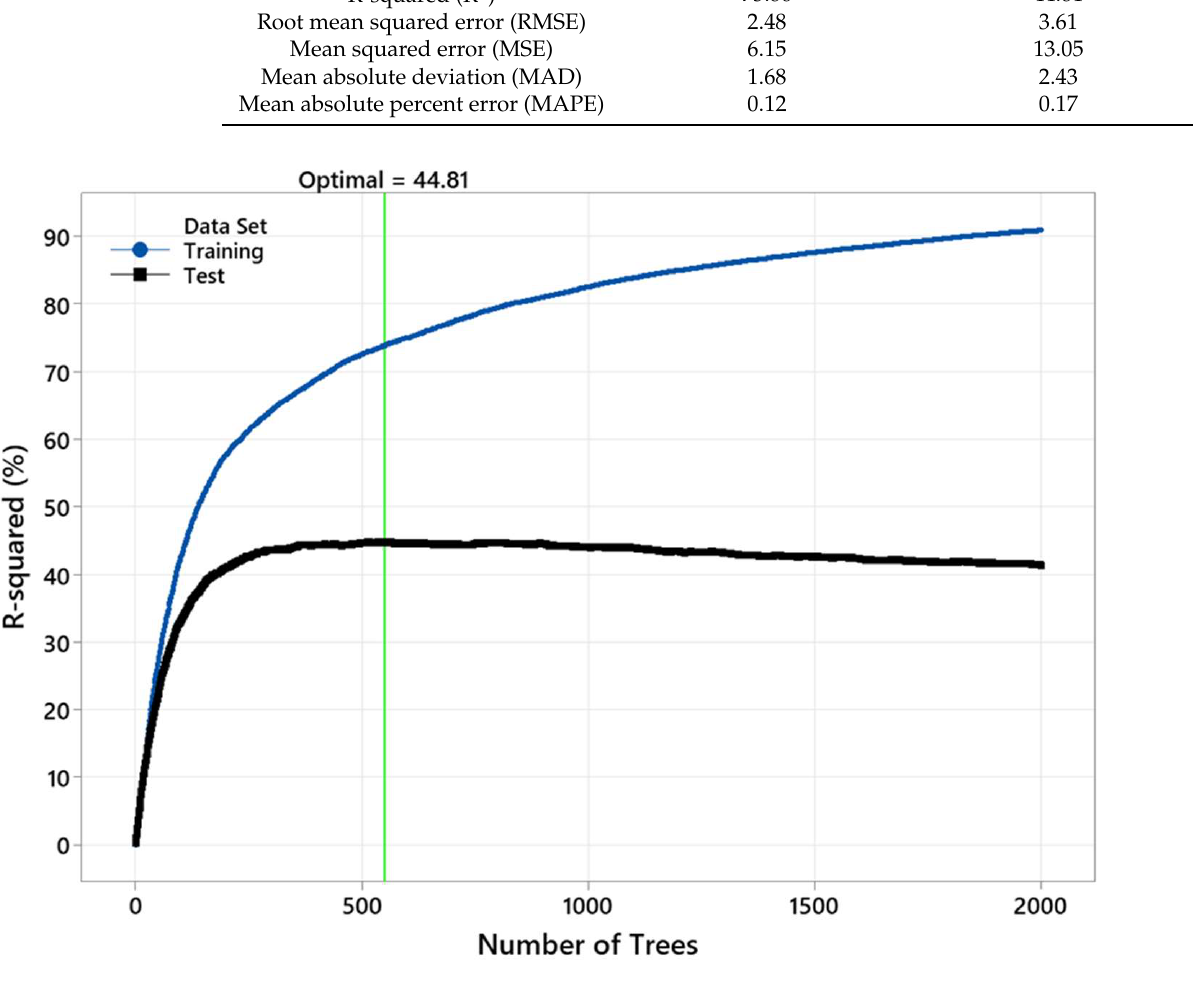
Figure 9. The variation in R 2 with the number of trees in the TreeNet model.